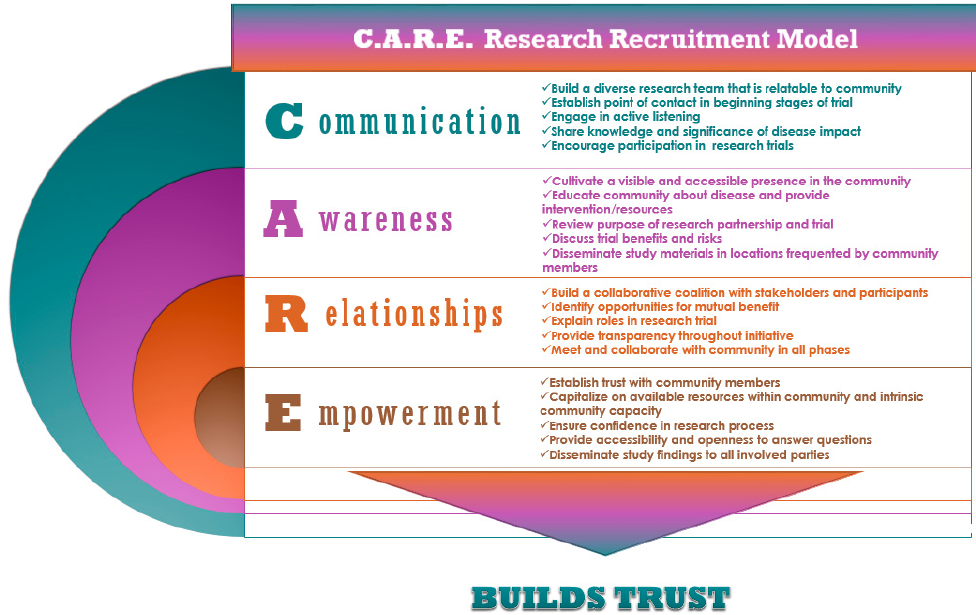
Figure 1. The C.A.R.E. (Communication, Awareness, Relationships and Empowerment) Research Recruitment Model. The culturally and historically sensitive C.A.R.E. Research Recruitment Model may be an effective means of recruiting and retaining predominantly Black/African American populations living in urban communities.